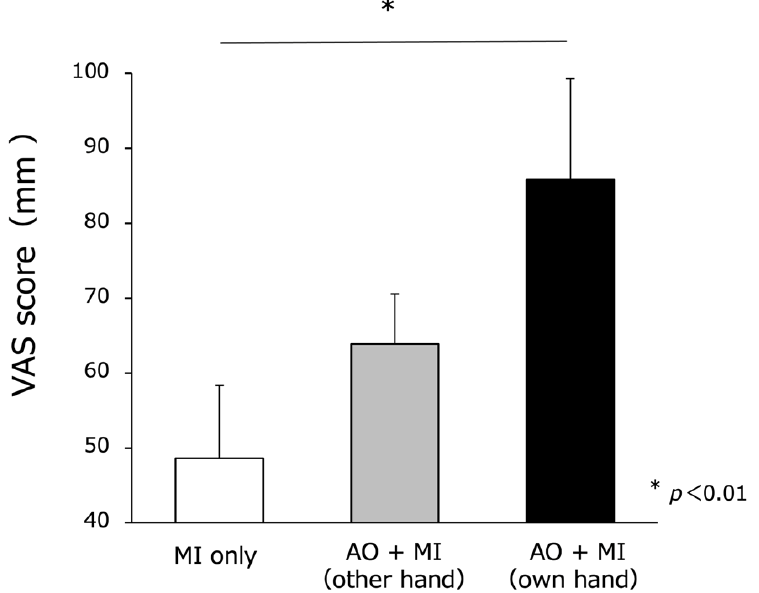
Figure 7. MI vividness. MI vividness was evaluated using visual analog scale (VAS) following NIRS measurements, and the effect observed showed a mean of 48.2 ± 9.7 mm for MI only, 56.7 ± 13.3 mm for other hand AO + MI and 82.2 ± 11.2 mm for own hand AO + MI.